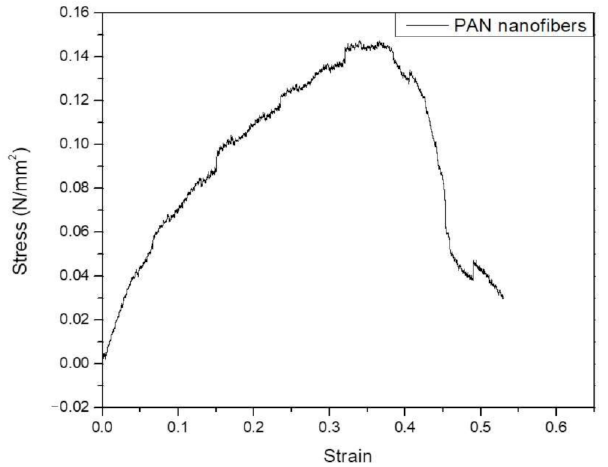
Figure 3. Stress–strain curve of the PAN nanofibrous